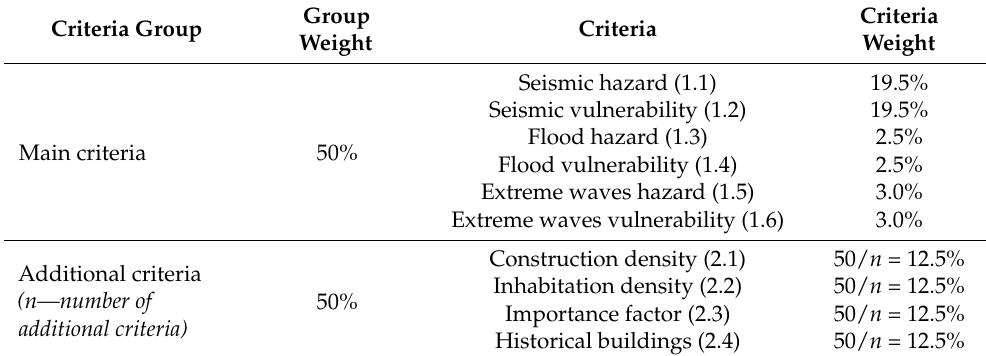
Table 5. An example of criteria weights for combined seismic–flood–extreme waves risk for Scenario S-F-EW Level 2.